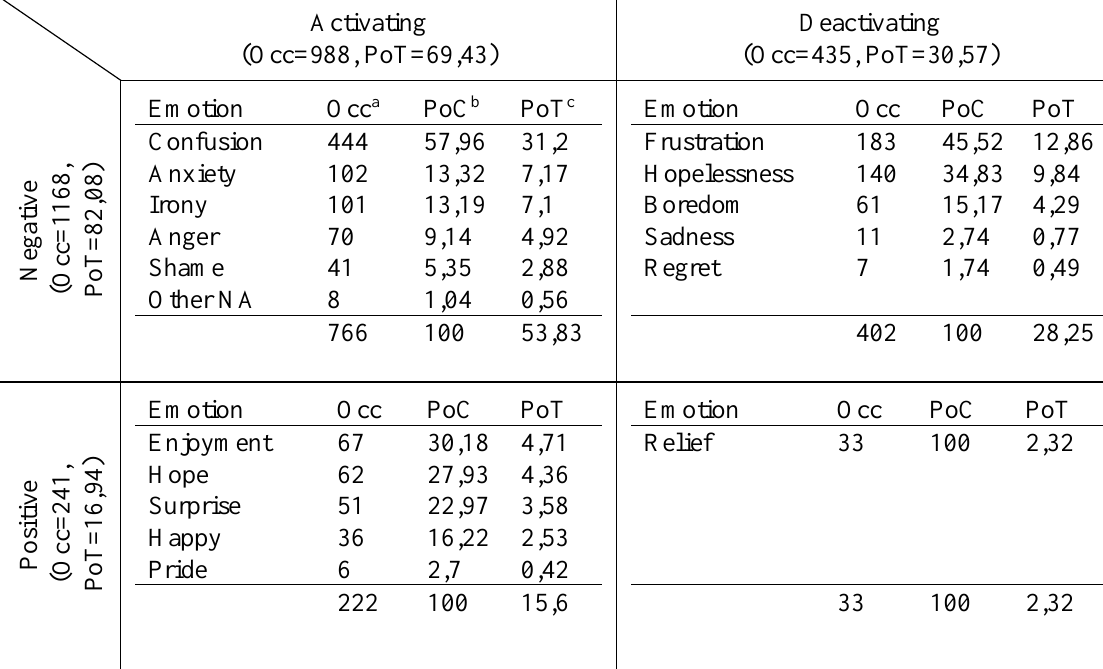
Figure 3. Distribution of emotions in the